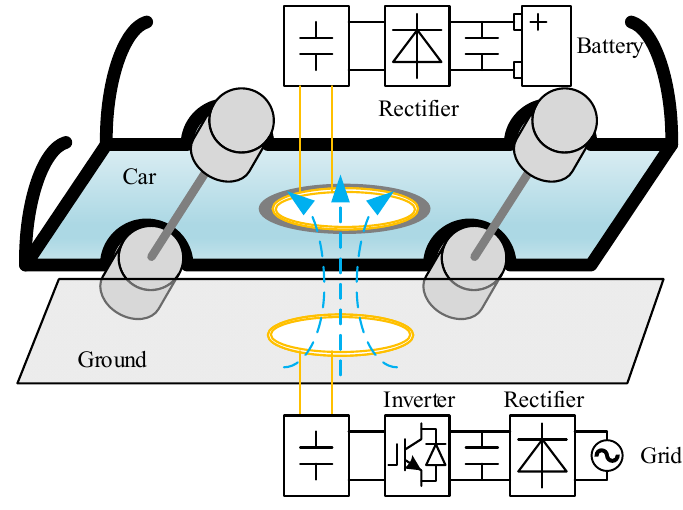
Figure 1. Basic structure of the WPT system.